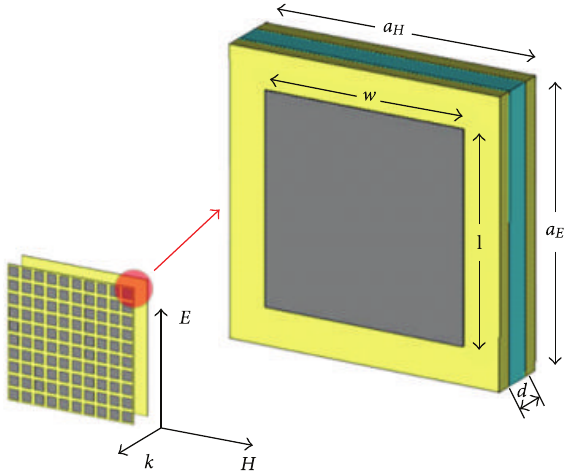
Figure 11: Schematic of the slab pair structure. A magnification of one unit cell of the slab pair structure (red shadowed area) is presented. 𝐸 , 𝐻 , and 𝑘 correspond to electric field, magnetic field, and the wave vector, respectively